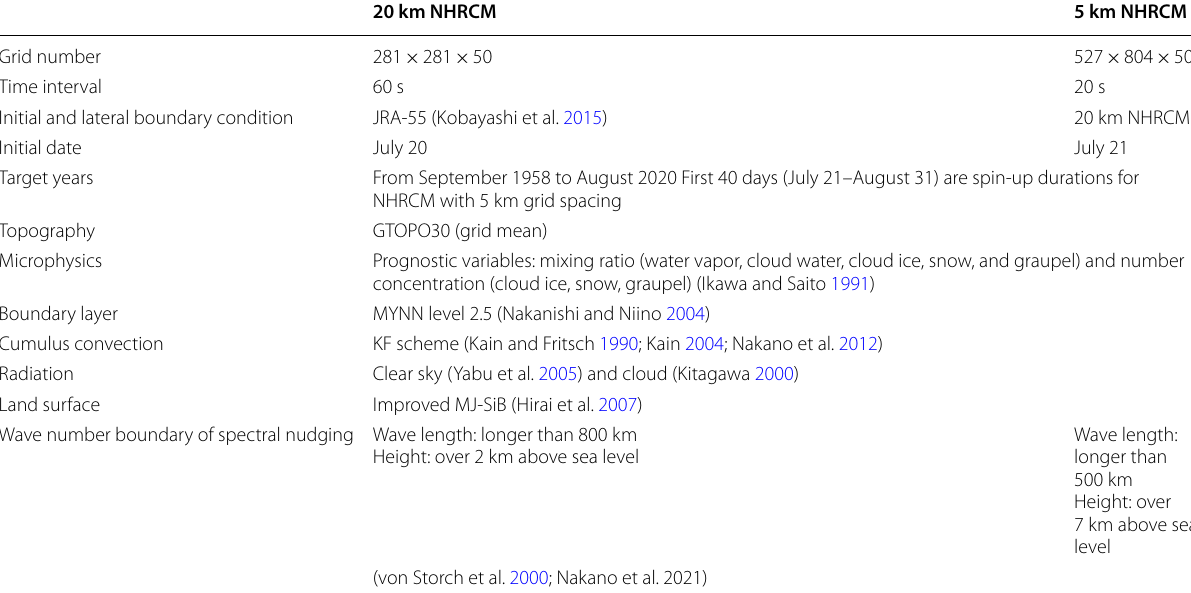
Table 1 Specifications of the numerical